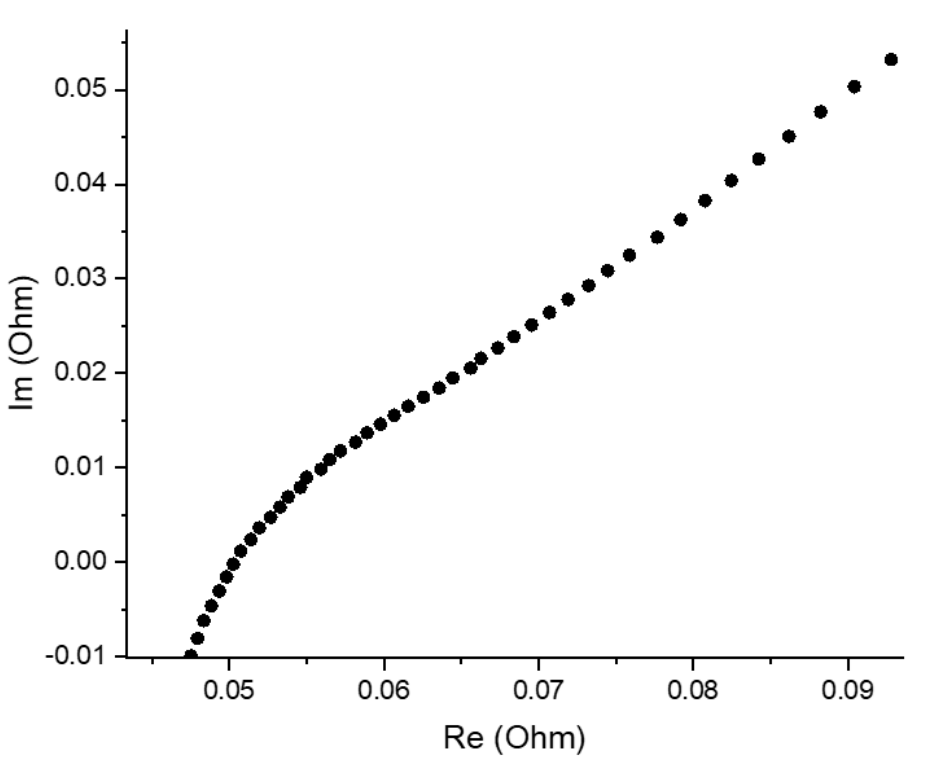
Figure 4. Nyquist plot for an AQBRFB measured at SOC: 100%, membrane: GP-IEM-103, temperature: 25 ◦ C, flow: through flow field, flow rate: 100 mL min − 1 . Posolyte composition: 1 M LiBrO 3 in 6 M H 2 SO 4 , negolyte composition: 0.8 M AQDSH 2 in 1 M H 2 SO 4 .